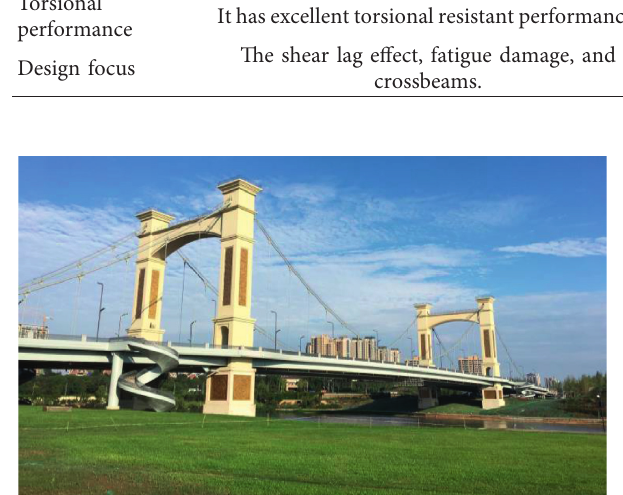
Figure 1: View of the Yunlongwan